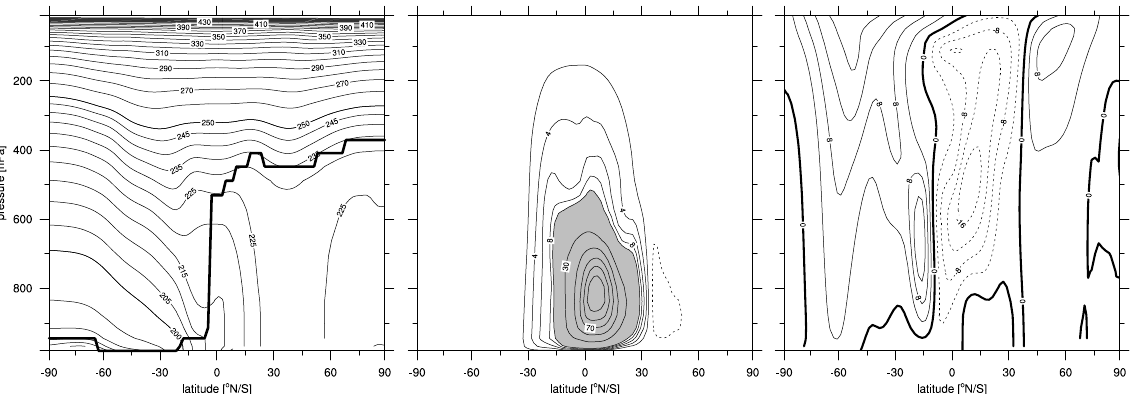
Fig. 7. Zonal-mean circulation for seasonally varying insolation during solstitial conditions in July (day 100–130). Left panel: potential temperature in K. Contour interval is 5K between 200, 250 and 10K otherwise. The black solid line depicts the tropopause (see text). Middle panel: mass stream function in units of 10 9 kgs − 1 . Solid (dashed) contour lines represent counterclockwise (clockwise) circulation. Contour interval is 2 between − 10 and 10, and 20 otherwise (gray shading). Left panel: zonal wind in ms − 1 . Contour interval is 4, with a thick zero contour line.